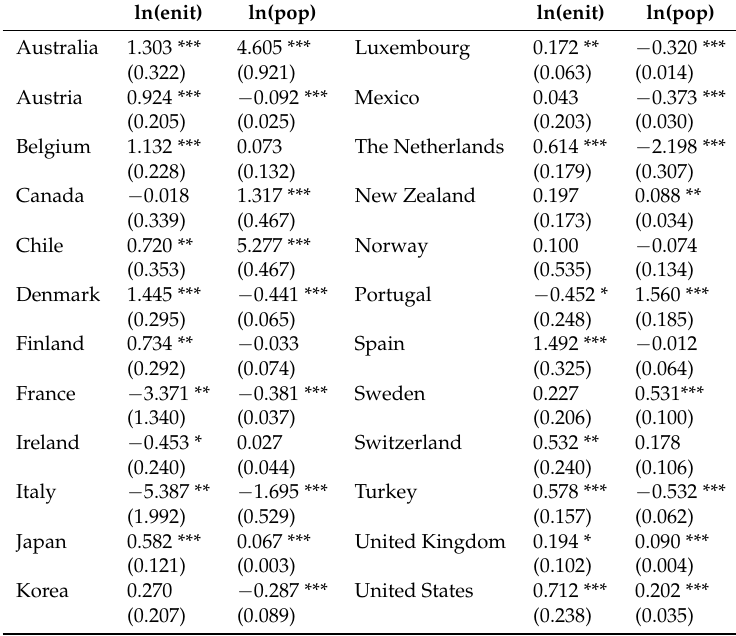
Table 6. Parametric estimates for the OECD countries. Semiparametric model.